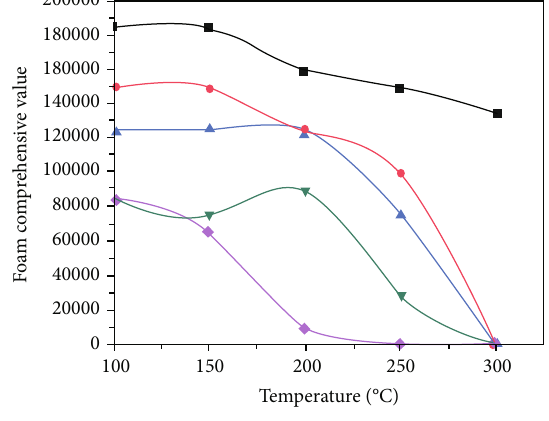
Figure 5: Results of foaming agent temperature tolerance